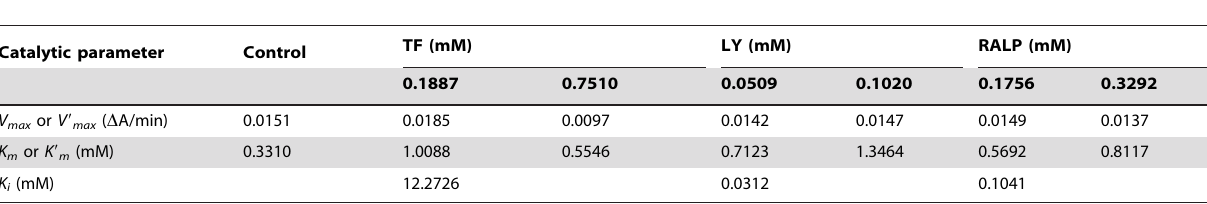
Table 1. Kinetics constants of angiotensin converting enzyme-catalyzed reaction at different peptide concentrations.